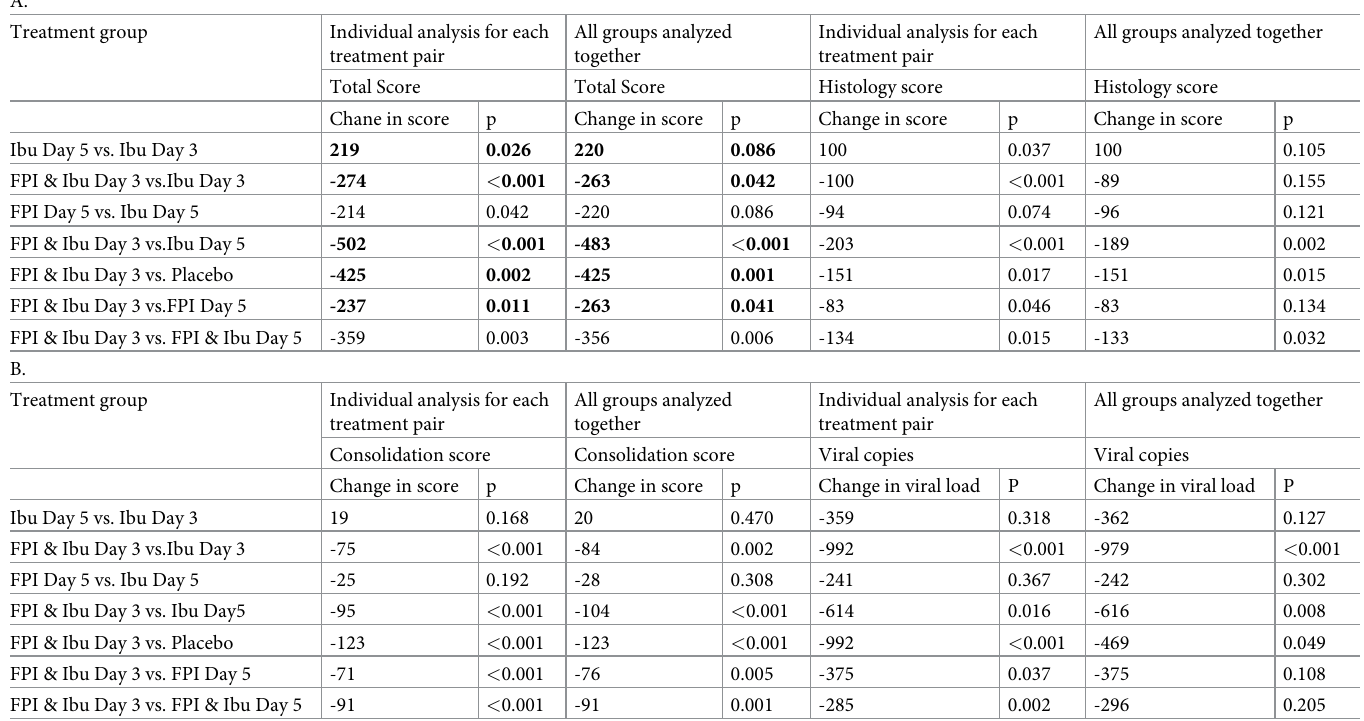
Table 5. A. Pairwise comparison of the overall treatment score and histology component for each pair of treatments analyzed separately (as if we had performed an indi- vidual experiment with two groups of six animals), and together. B. Pairwise comparison of the consolidation component of the overall treatment score and the virus copies for each pair of treatments analyzed separately (as if we had performed an individual experiment with two groups of six animals), and together.